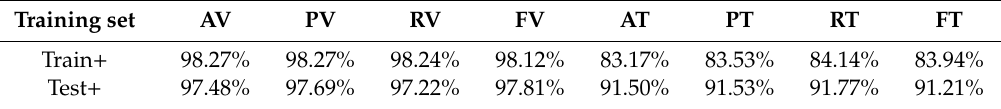
Table 6. Performance of intrusion detection by using di ff erent training